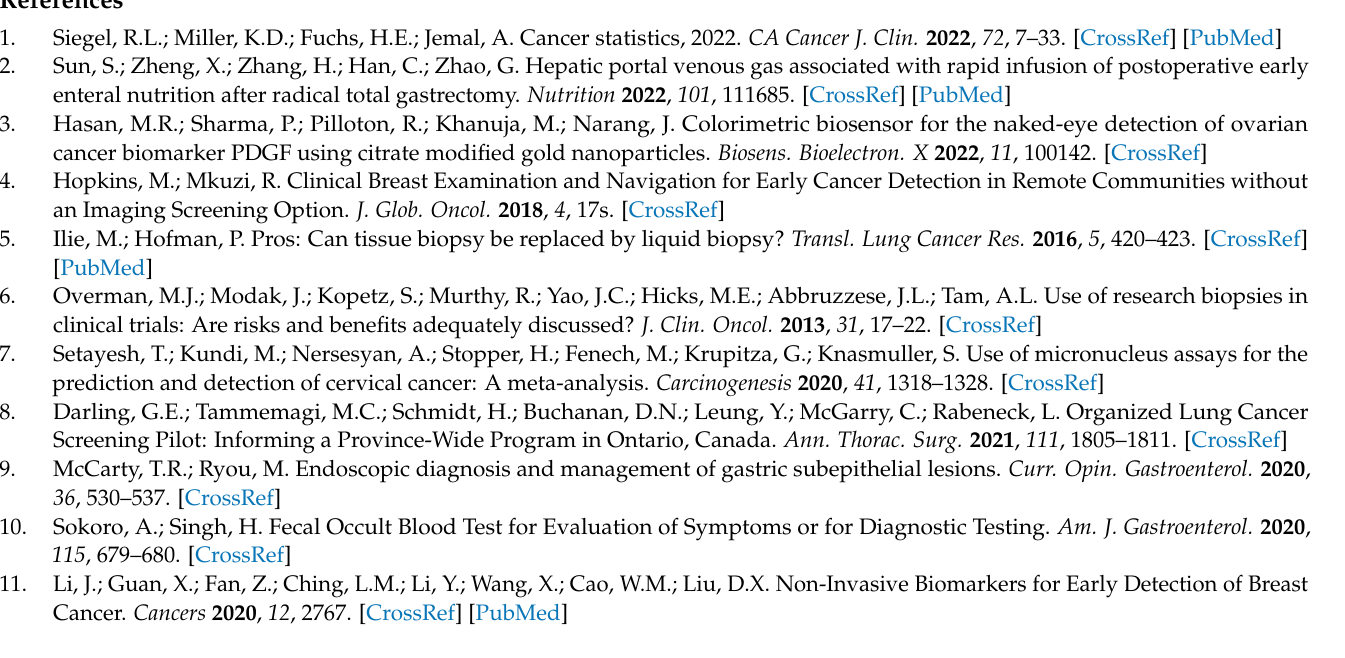
Figure 3. Current clinical trials using cfDNA in cancer settings. See the website (clinicaltrials.gov, accessed on 12 May 2022) for details of trials. Search performed on 12 May 2022.